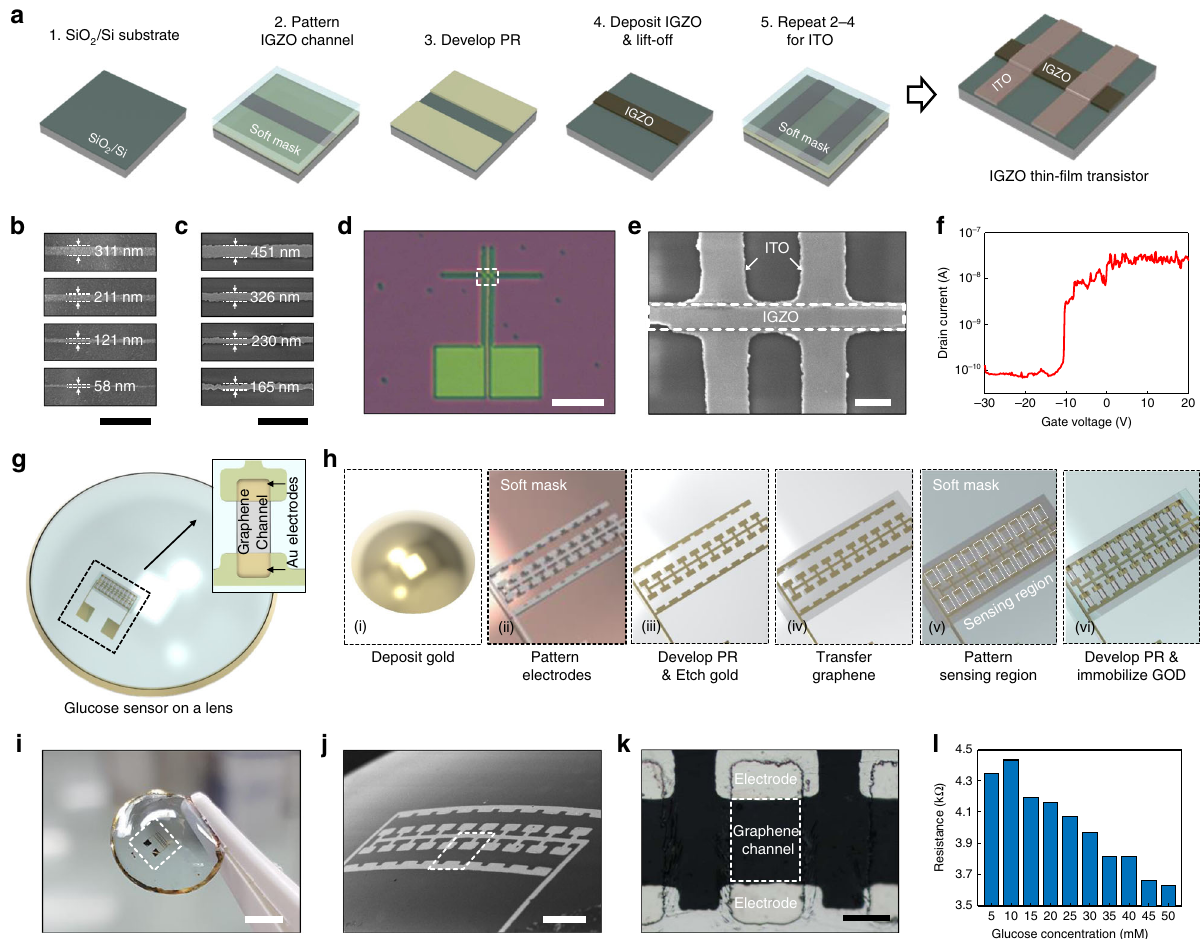
Fig. 6 Soft photomask provides generic and multiple feature patterning. a Experimental procedure to fabricate an IGZO thin- fi lm transistor. b , c SEM images of Cr pattern embedded in soft photomask ( b ) and corresponding IGZO pattern ( c ). Scale bars: 2 μ m. d Optical microscopy image of IGZO thin- fi lm transistor. Scale bar: 10 μ m. e SEM images of an IGZO channel and ITO electrodes. Scale bar: 500nm. f Transfer curve of an IGZO thin- fi lm transistor. Drain bias is 10.1V. g Schematic illustration of glucose sensor on a contact lens. h Fabrication process for glucose sensor directly patterned on a contact lens. i Photograph of electrode-patterned contact lens. Scale bar: 3mm. j SEM image of Au electrodes patterned on the contact lens. Scale bar: 200 μ m. k Optical microscopy image of con fi ned graphene channel and Au electrodes. Scale bar: 50 μ m. l Electrical resistance of glucose sensor depending on glucose change of the graphene channel, which results from oxidation of glucose 39 . Figure 6h depicts a fabrication process of glucose sensor on a contact lens. A 100 nm-thick Au layer with a 10 nm- thick Cr adhesive layer was deposited on a commercial contact lens (NEON, Blue). Cr/Au fi lm was patterned by photolitho- graphy followed by etching process to form the electrodes (Fig. 6g, h). We transferred the graphene onto the contact lens and con fi ned the graphene channel by SU-8 photoresist (Fig. 6i).